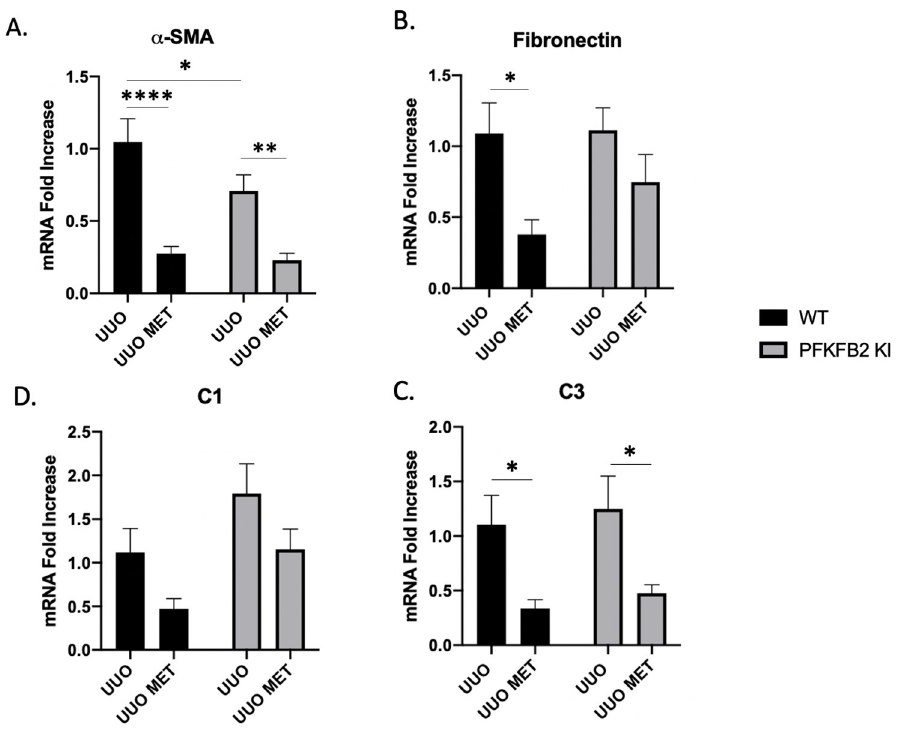
Fig 4. mRNA expression of markers of fibrosis for WT and PFKFB2 KI UUO kidneys ± metformin measured by RT-PCR (A-D). α -smooth muscle actin ( α -SMA) was significantly lower with the addition of metformin for WT and PFKFB2 KI kidneys ( A ���� p < 0.001 and �� p = 0.002 respectively). Similarly, mRNA expression of fibronectin was significantly less in WT UUO kidneys treated with metformin compared to control UUO comparisons ( B � p = 0.02) with a trend towards similar effect in PFKFB2 KI kidneys. PFKFB2 KI UUO control kidneys had significantly less expression of α -SMA compared to their WT counterparts ( A � p = 0.04). mRNA expression of collagen 3 (C3) was significantly reduced with the addition of metformin ( C , p < 0.05) with trends towards a similar pattern in Collagen 1 (C1) ( D ) Mean +